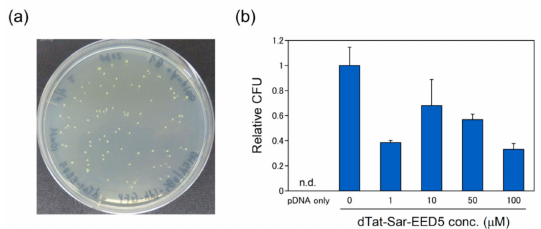
Figure 7. The pDNA delivery into E. coli cells. ( a ) Ampicillin-resistant colonies of E. coli . The pDNA complex (BP100-(KH) 9 / pBS-ldhGFP) at N / P ratio 2.0 was introduced into 10 µ M dTat-Sar-EED5 treated E. coli cells. ( b ) E ff ects of dTat-Sar-EED5 concentrations on the transformation e ffi ciency of E. coli . The pDNA delivery was carried out under di ff erent concentrations of dTat-Sar-EED5 (0, 1, 10, 50 and 100 µ M). The N / P ratio was set to 5.0, where a fixed amount of plasmid DNA (1 µ g) was mixed with various amounts of peptide BP100-(KH) 9 . ‘pDNA only’ means plasmid DNA alone without BP100-(KH) 9 and dTat-Sar-EED5. ‘0 µ M of dTat-Sar-EED5 (cid:48) means pDNA complex (BP100-(KH) 9 / plasmid DNA) without dTat-Sar-EED5. Data were normalized by ‘0 µ M dTat-Sar-EED5 (cid:48) . Data are the mean ± SD of three